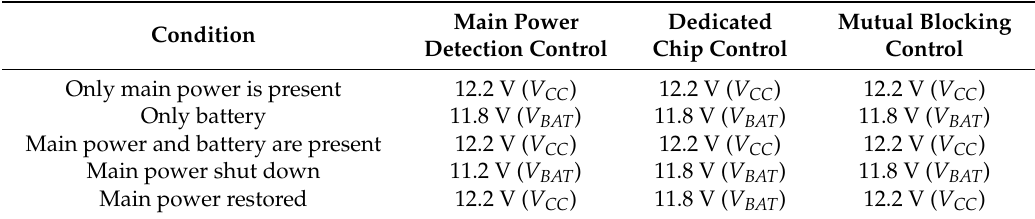
Table 1. Output voltage to equipment.